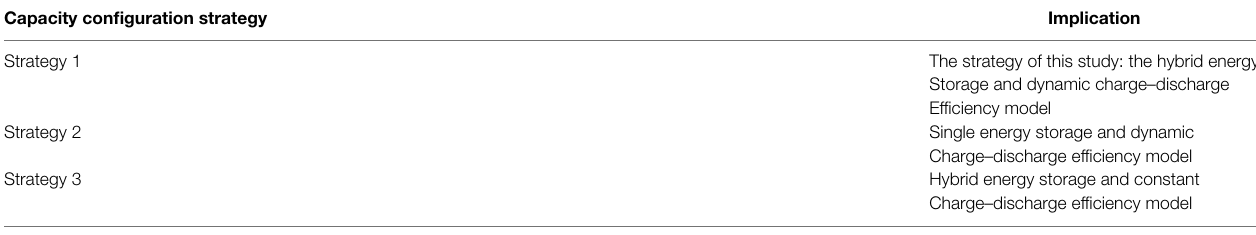
TABLE 4 | Capacity optimization strategy comparison settings.